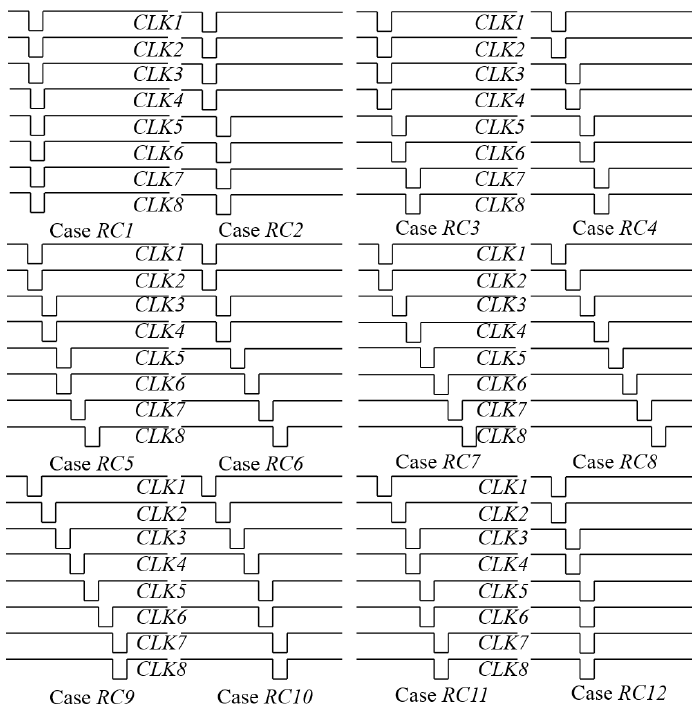
Figure 4. Twelve clock waveforms corresponding to 12 region cases.